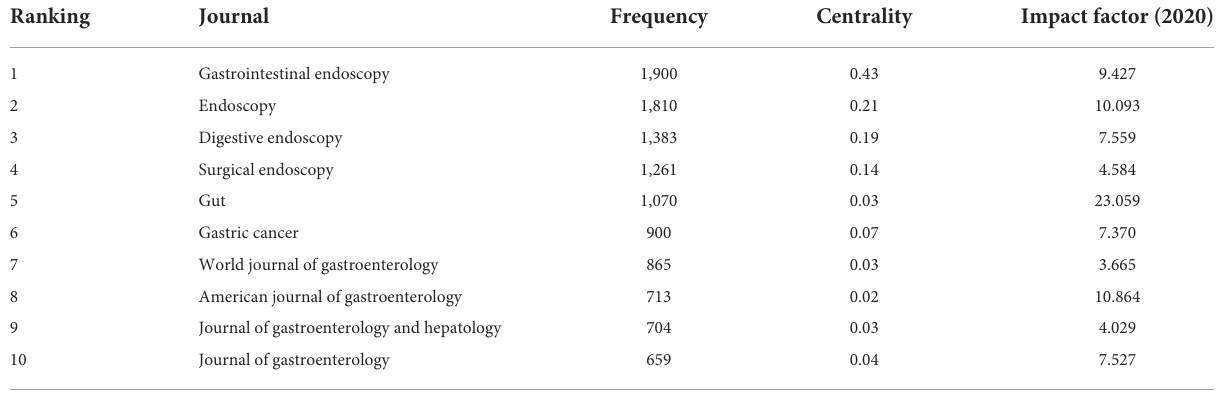
TABLE 6 Top 10 highly cited journals in research of ESD, 2006-2020.